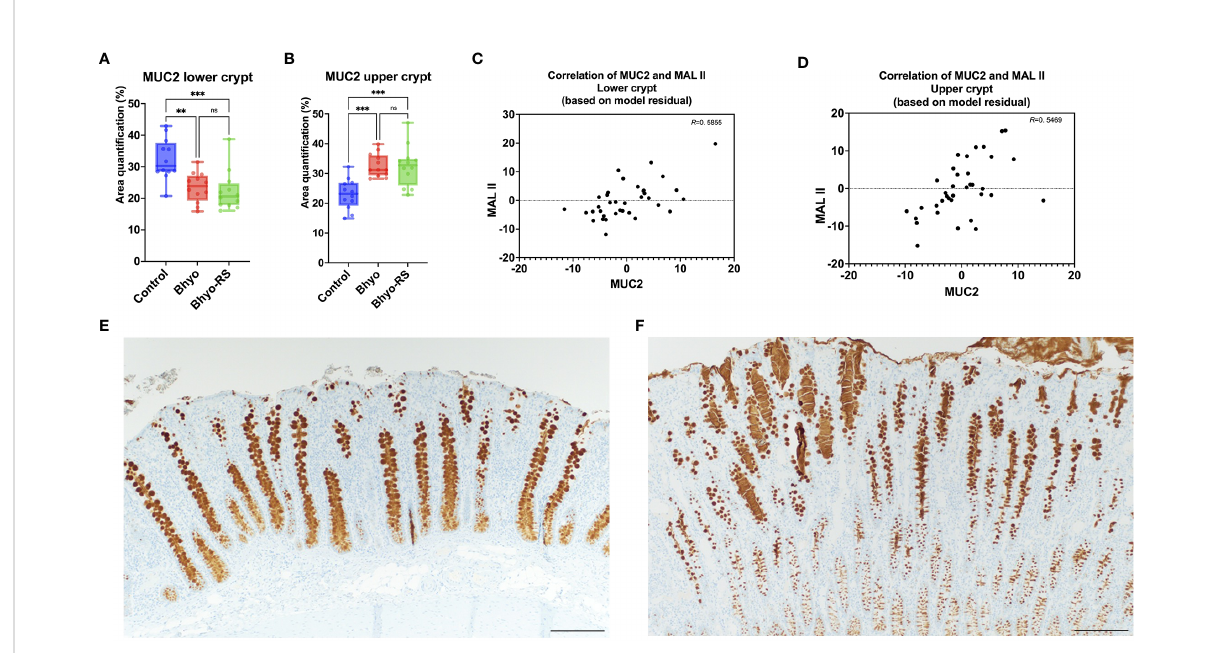
FIGURE 5 MUC2 expression was signi fi cantly different between the three groups, both in the lower and the upper half of the colonic mucosa (A, B) , P < 0.05). There was a moderate correlation between the expression of MUC2 and MAL II (C) , lower half, R =0. 5855, P < 0.05, and upper half, (D) , R =0. 5469, P < 0.05). There was more MUC2 expression in the lower half of the colonic mucosa in the controls (E) , while the Bhyo (F) and Bhyo-RS groups had more expression in the upper halves ( P < 0.05). Bar = 200 µm. **, P ≤ 0.01; ***, P ≤ 0.001; ns, not signi fi